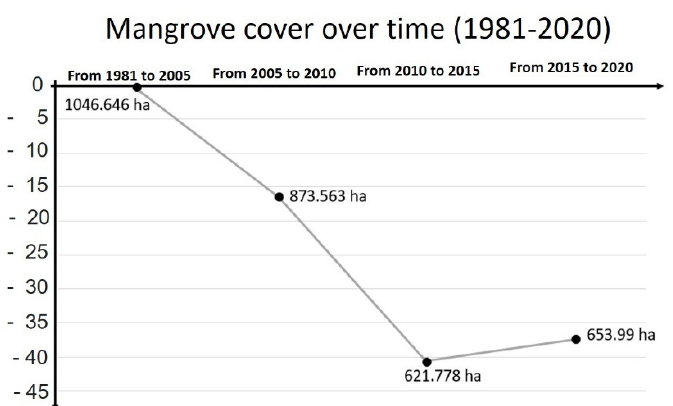
Figure 9. The decreasing trend of the mangrove cover area from 1981 to 2010 is evident. However, due to a reforestation activity from 2008 to 2013, the mangrove has recovered more than 30 ha of the mangrove area during the last two periods.